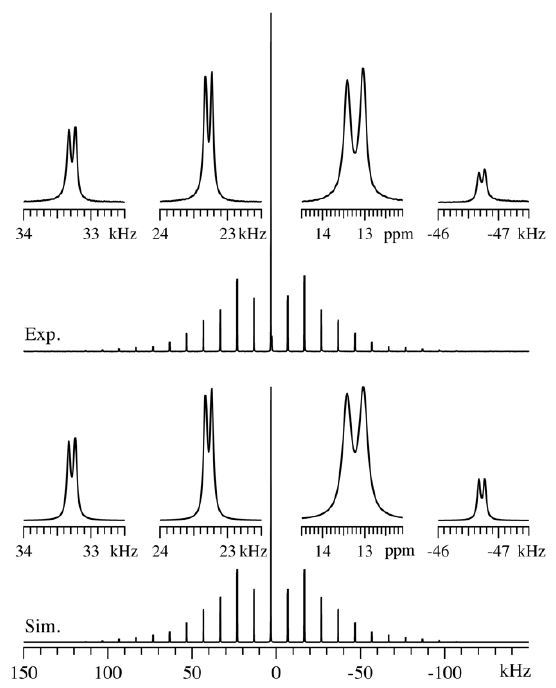
Figure 6. Experimental and simulated 27 Al MAS NMR spectrum (22.3 T, ν R = 10.0 kHz) of the central and satellite transitions for chromate AFt. The insets show expansions of the central-transition region (ppm scale) and selected spinning sidebands from the satellite transitions (kHz scale), all illustrating the clear resolution of two distinct Al sites.